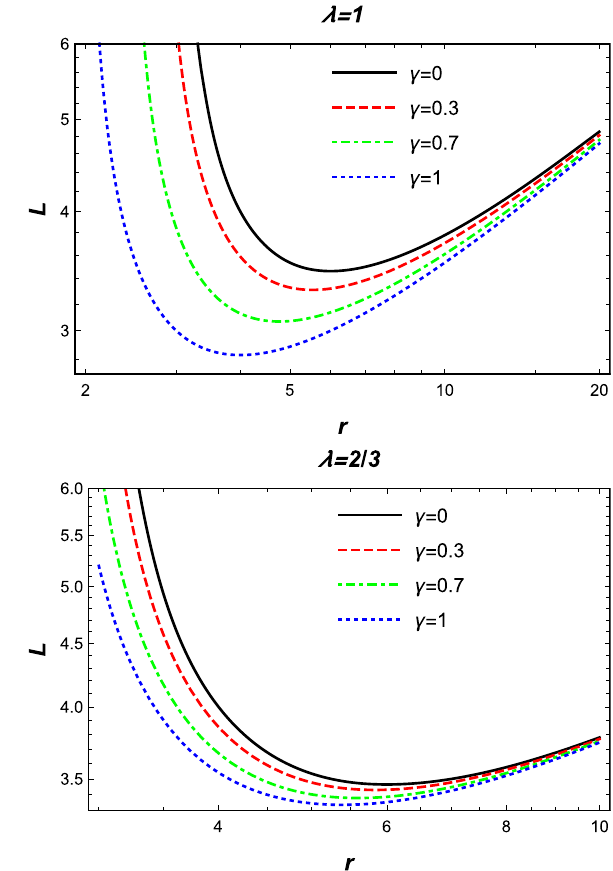
Fig. 3 Radial dependence of L for the different values of parameters γ and λ . Where M = m =